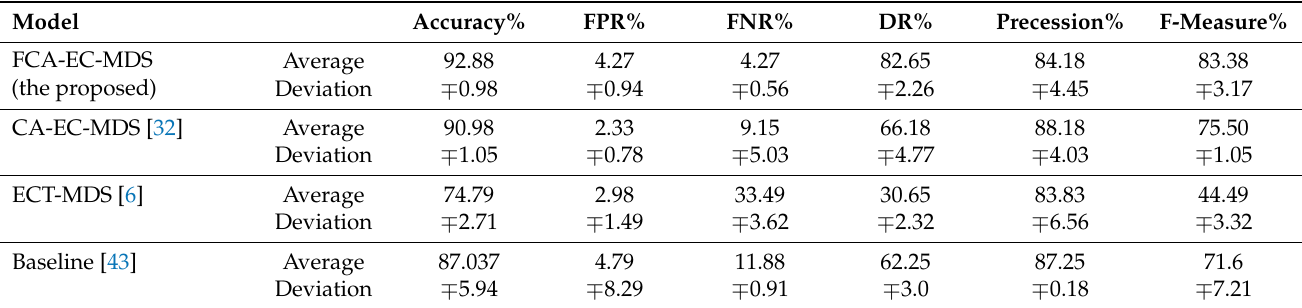
Table 3. Results of performance evaluation.